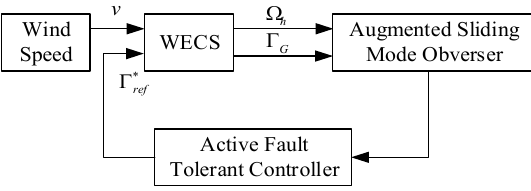
Figure 2. Overall block diagram of fault-tolerant control for the WECS.